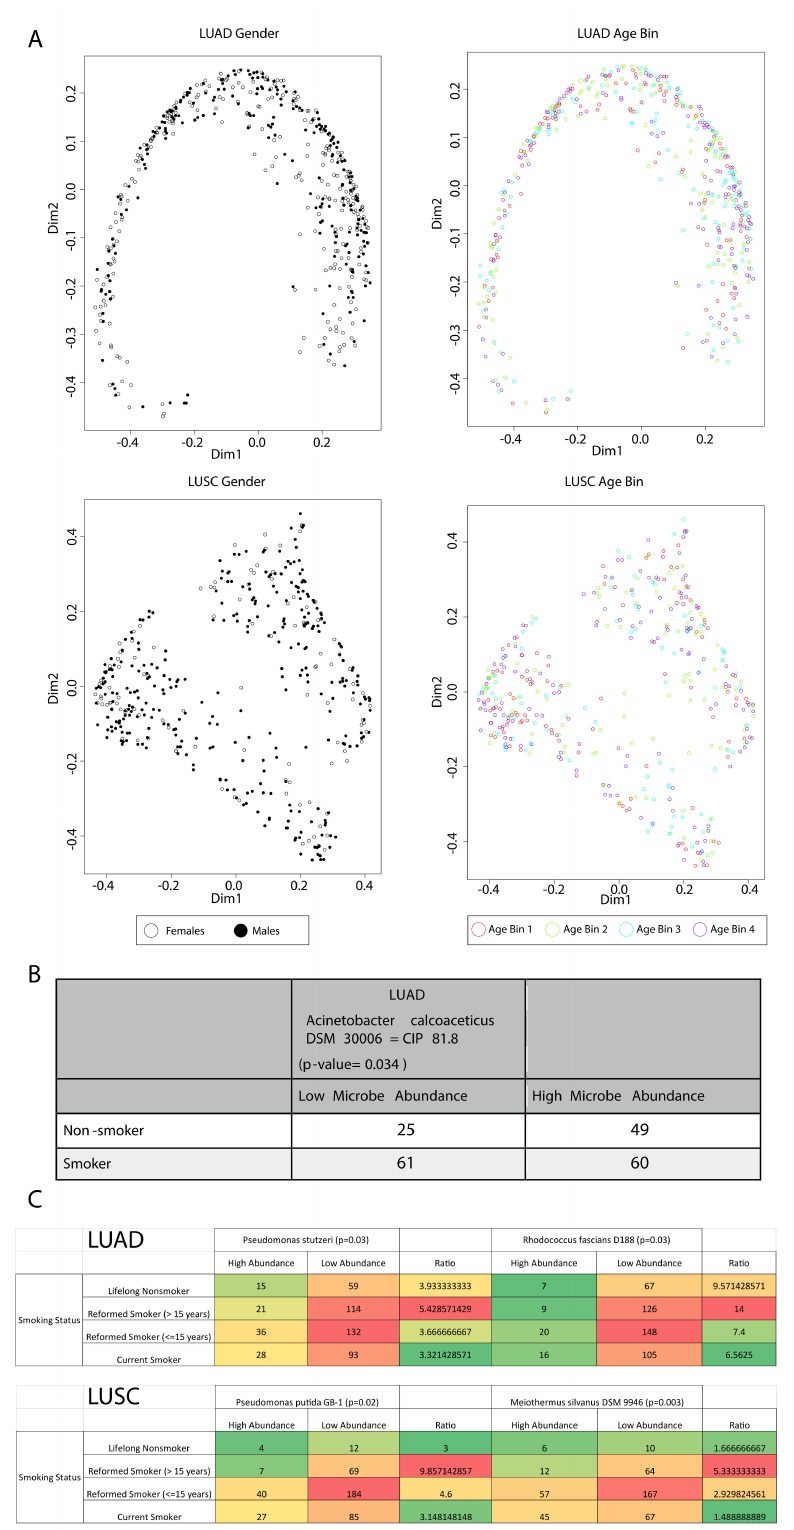
Figure 3. Principle coordinates analysis (PCoA) plot and smoking correlations. ( A ) PCoA plot demonstratingdifferenceinmicrobialabundancebetweenageandgenderinLUADandLUSC.( B )Smoking correlation with the LUAD-associated microbe Acinetobacter calcoaceticus DSM 300,006 = CIP 81.8 abundance ( χ 2 test, p < 0.05). ( C ) Smoking correlation with the abundance of microbes with reformed smokers (logistic regression, p -value <